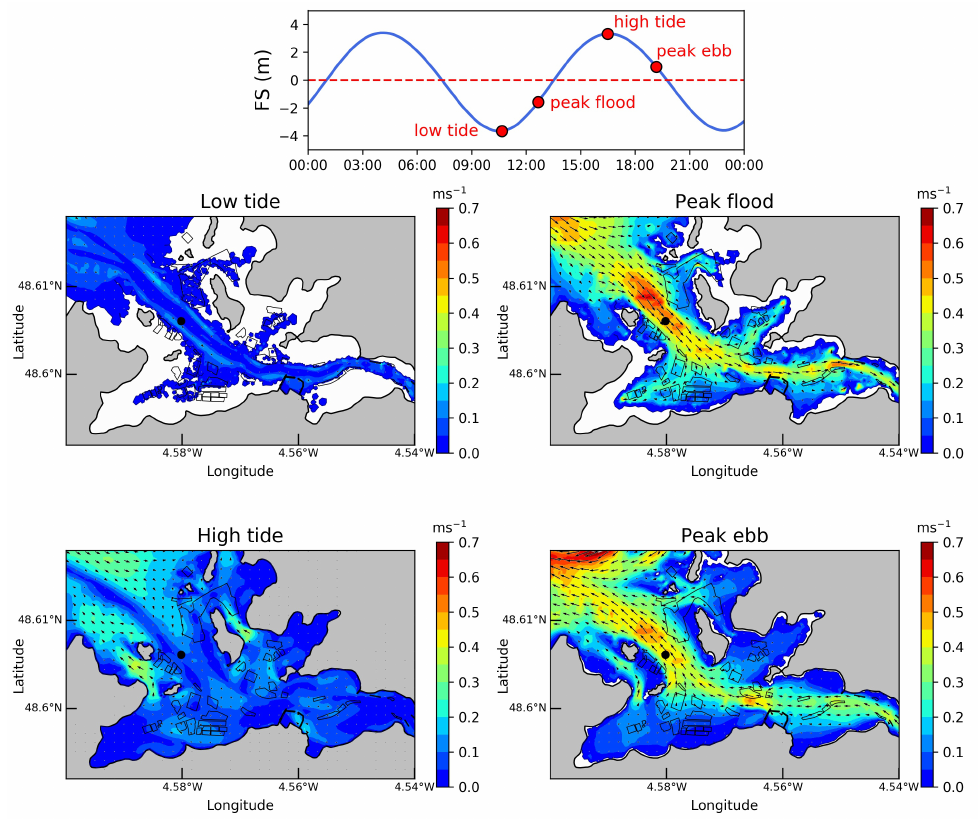
Figure 9. Depth-averaged current velocities at low tide, peak flood, high tide, and peak ebb of a mean spring tide predicted in configuration E 3 . The top figure shows the time series of the free-surface elevation (with respect to mean water depth) in the access channel to the estuary (the location is indicated with a black circle on sub-figures). Time steps retained for the extraction of synoptic predictions are displayed with red circles on top figure. Black lines delimit the extents of areas covered by oyster